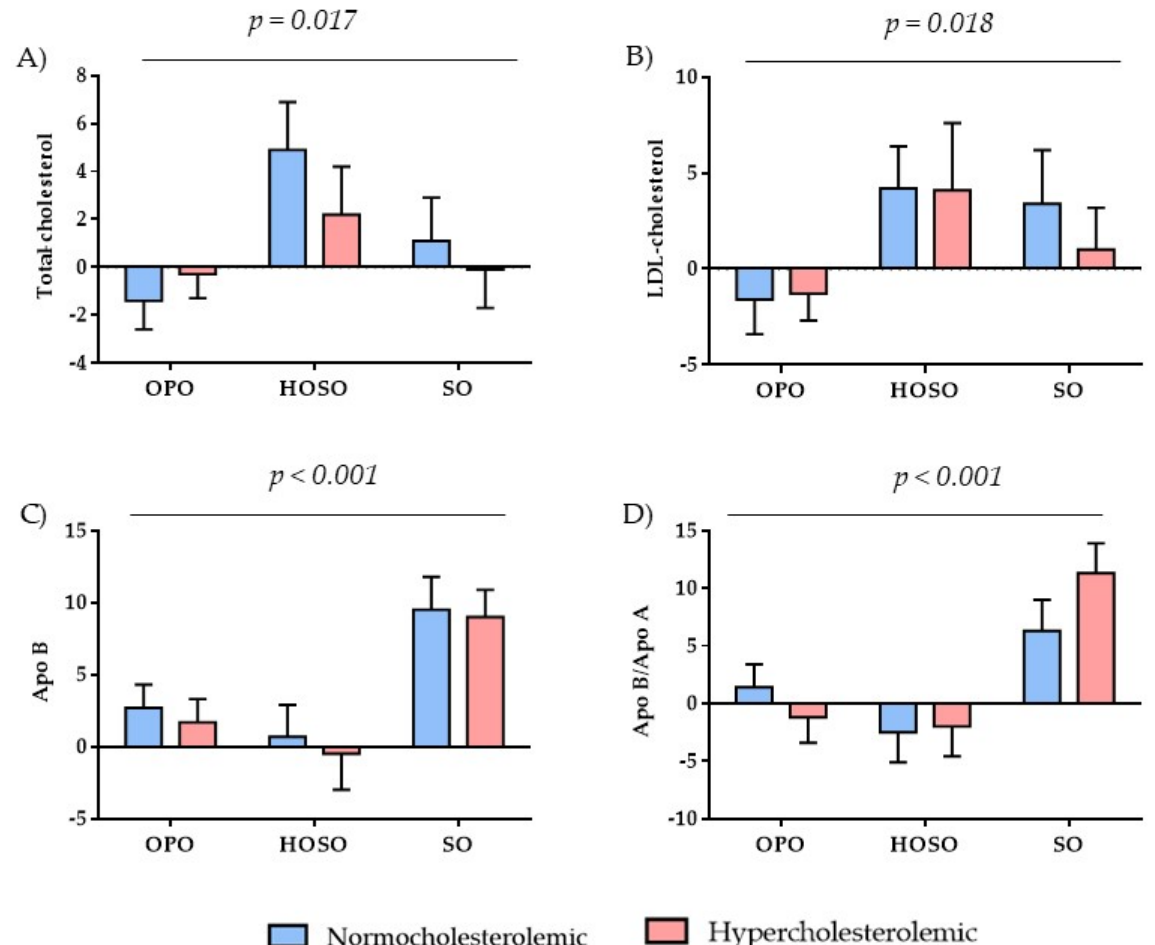
Figure 2. Values represent the rate of change calculated from [(post-treatment value − pre-treatment value)/pre-treatment value] and the error bars represent standard error of mean (both expressed as percentage). n per group: normocholesterolemic: Olive pomace oil (OPO): n = 65, high oleic sunflower oil (HOSO): n = 34, sunflower oil (SO): n = 31; hypercholesterolemic: OPO: n = 67, HOSO: n = 30, SO: n = 37. According to the linear mixed model, the oil effect was significant: ( A ) p = 0.017; ( B ) p = 0.018; ( C ) p < 0.001; ( D ) p < 0.001. There were no significant differences between the study groups, neither oil × group interaction ( p > 0.05). Apo: